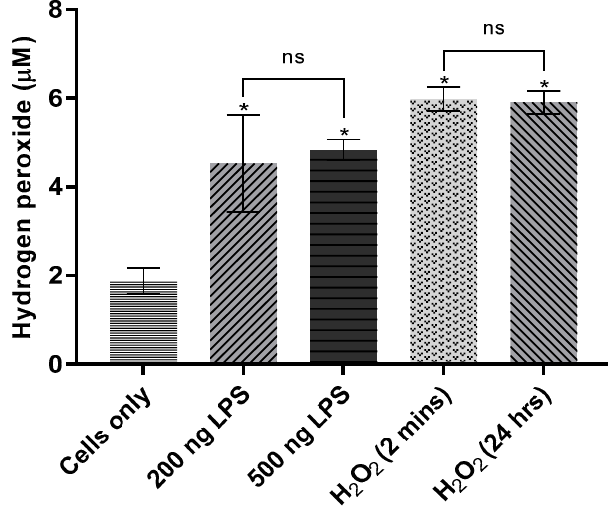
Figure 6. Effect of lipopolysaccharides on hydrogen peroxide production in RAW 264.7 cells. Cells were seeded in 24-well cell culture plates at a density of 1 × 10 5 cells/well. Upon reaching ~50% confluency, treated cells were spiked with LPS in two concentrations (200 ng/mL and 500 ng/mL, in triplicate), then incubated for 24 h. After calibration of the Pt-MEA against H 2 O 2 in complete cell culture medium (DMEM), amperometry was performed in each well for four minutes with a potential step of +0.7 V against an Ag/AgCl reference electrode. The sensitivity obtained during calibration (9.975 pA/ µ M; R 2 = 0.9995) was used to translate current for each experimental condition to normalized H 2 O 2 concentration ( µ M). Data shown correspond to Electrode 1 (E1), the electrode nearest the cells. One-way ANOVA ( n = 5, p = 0.002) was performed to assess the significance of differences among all group mean concentrations, followed by the Tukey–Kramer test to assess pairwise significant differences ( n = 5, * p < 0.05).